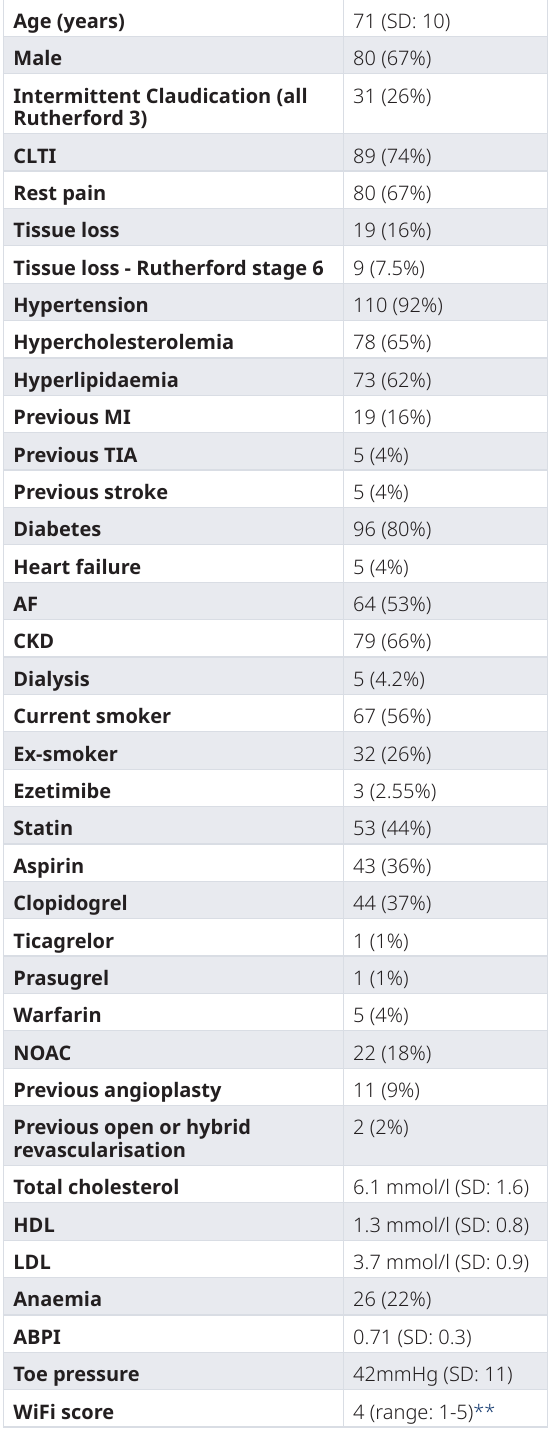
Table 1. Baseline characteristics per patient.